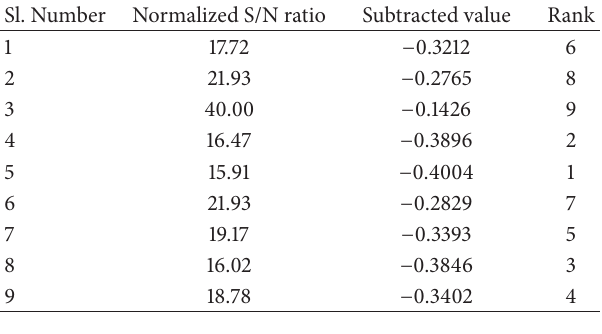
Table 10: Normalized ratio and MOORA ranking. Sl. Number